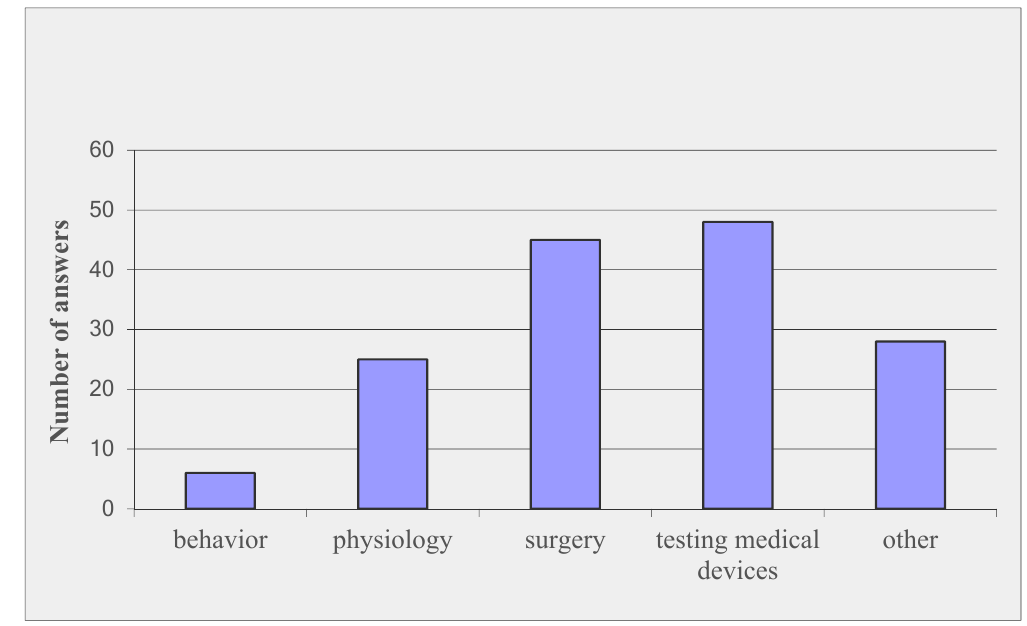
Figure 1. Main field of research using sheep (multiple answers possible).